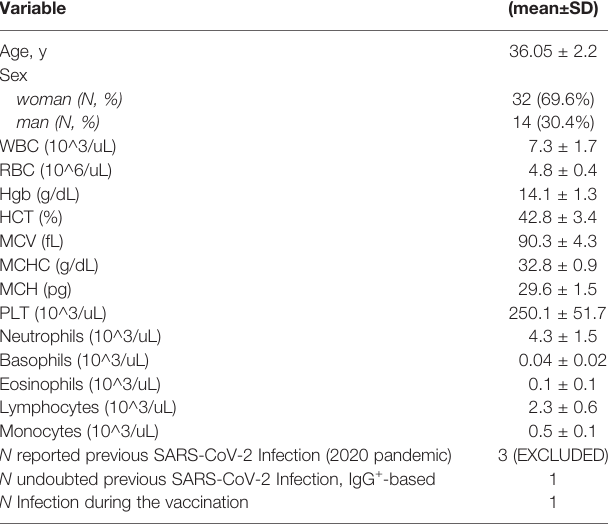
TABLE 1 | Baseline